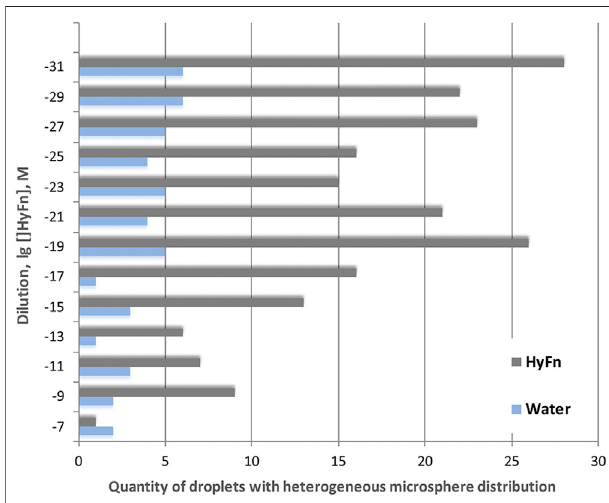
FIGURE13| Comparisonofthenumberofdropswithspecialstructures (substantially uneven distribution of microspheres) in HyFn dilutions and water “ dilutions ” out of 36 drops for each HyFn or respective water